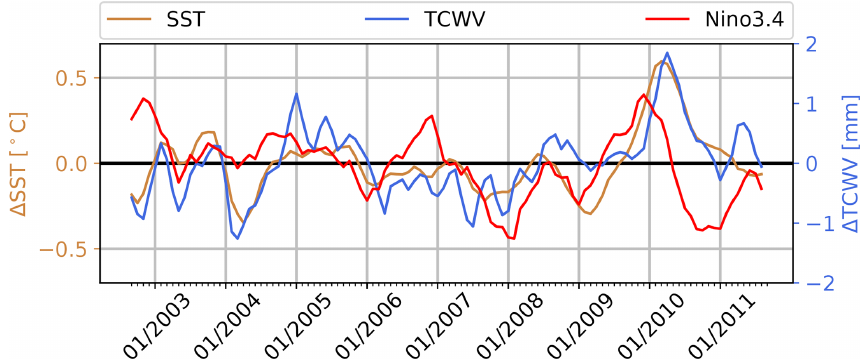
Figure 7. Time series of the tropical Atlantic 3-month running mean anomalies of SST (orange) and TCWV (blue). In red the qualitative progress of the Nino3.4 index is shown.